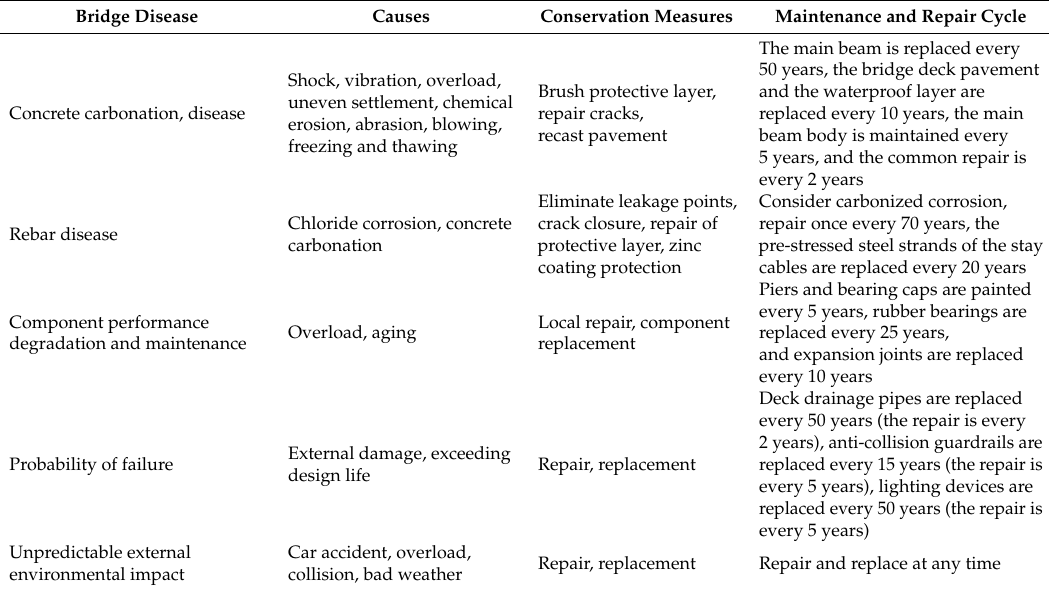
Table 4. Summary table of the cable-stayed bridge maintenance, along with its maintenance cycle and causes